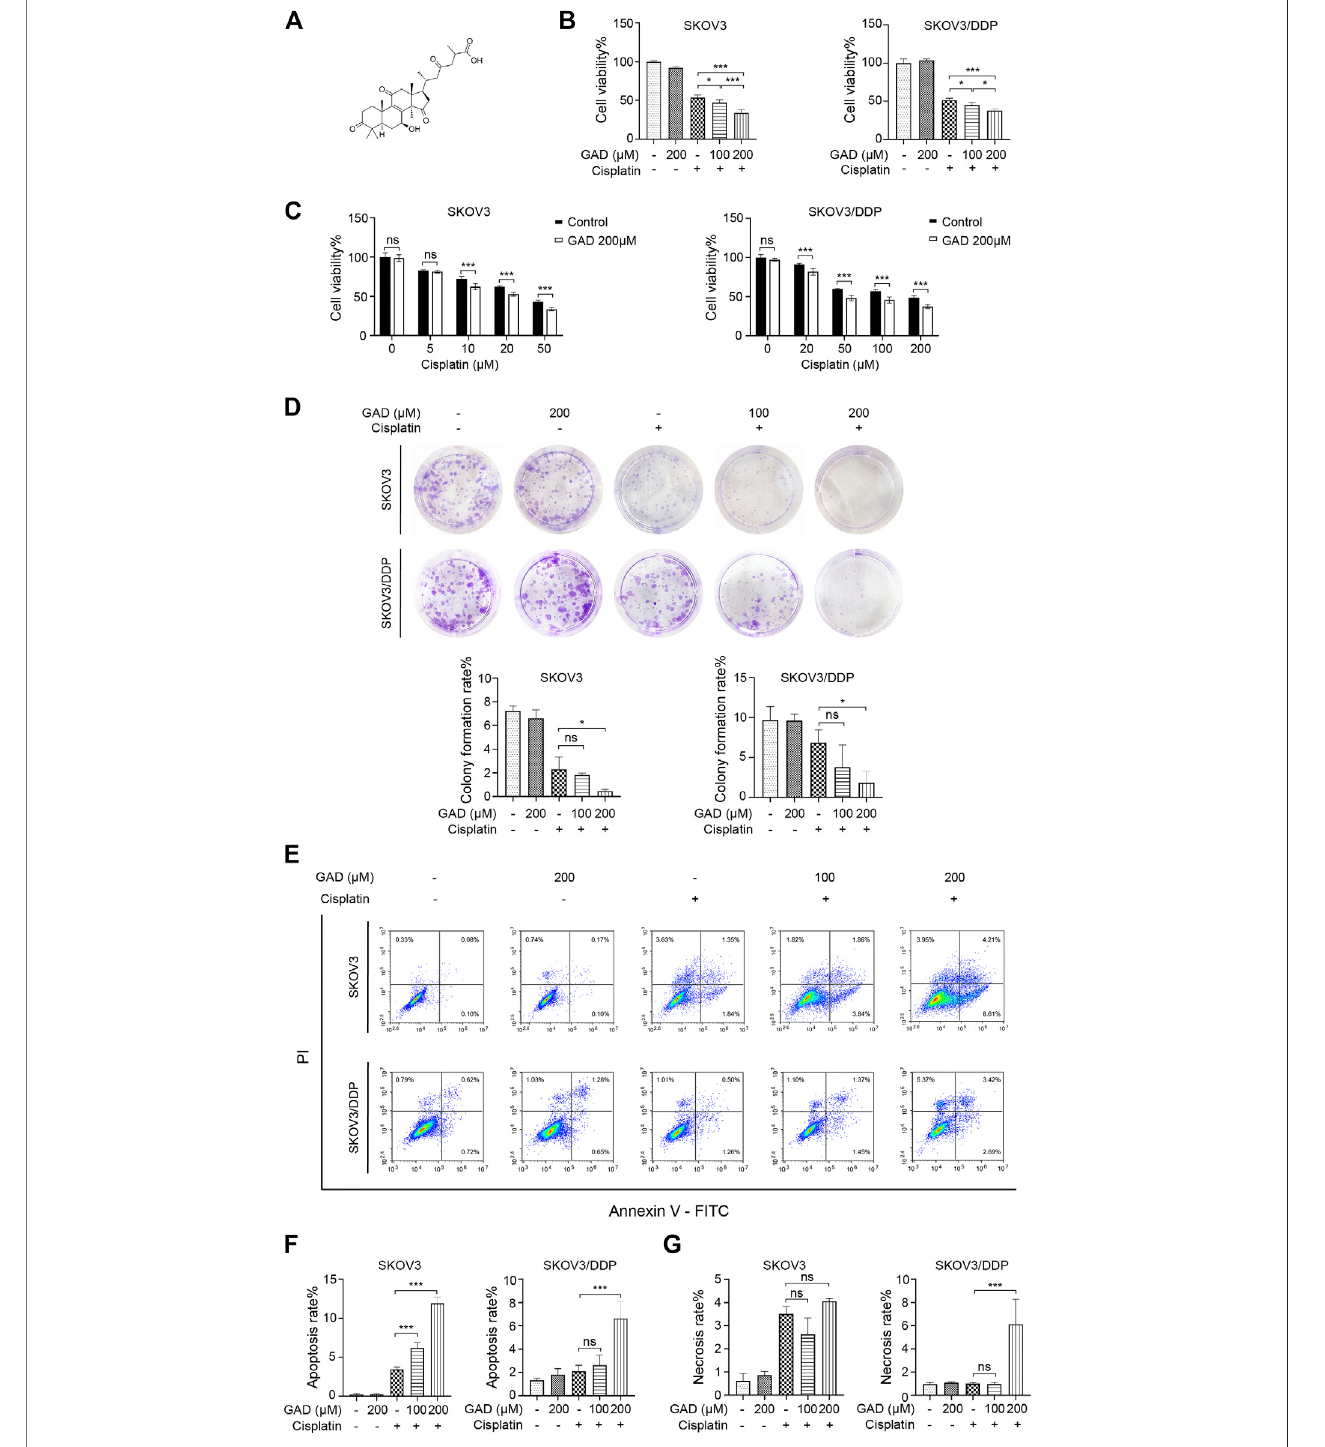
FIGURE 3 | Ganoderic acid D (GAD) enhanced cisplatin-induced cytotoxicity in cisplatin-sensitive and cisplatin-resistant ovarian tumor cell lines. (A) The chemical structure of GAD. (B) The cell viability of SKOV3 and SKOV3/DDP treated with GAD and cisplatin (40 μ M for SKOV3 and 200 μ M for SKOV3/DDP) for 24 h. (C) The cell viability of SKOV3 and SKOV3/DDP exposed to 200 μ M GAD and different concentrations of cisplatin for 24 h. (D) The images of colony formation and corresponding quantitative analysis. (E – G) The apoptosis and necrosis of SKOV3 and SKOV3/DDP and their corresponding quantitative analysis. Data are presented as the mean ± SD ( n = 3). *** p < 0.001; ns, no statistical signi fi cance.